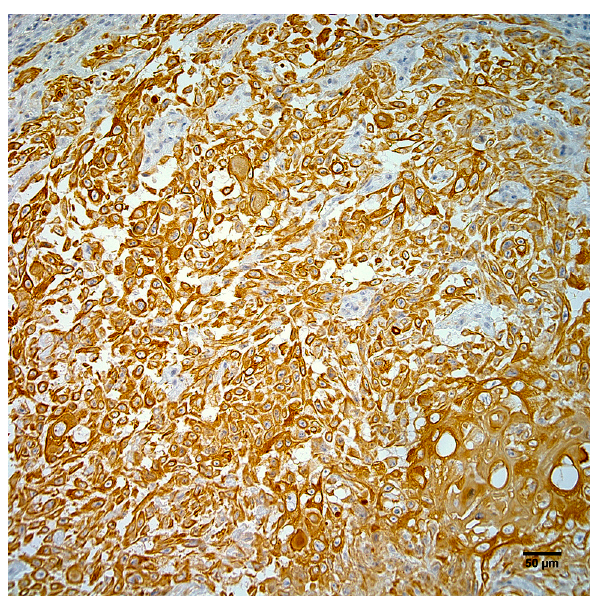
Figure 4. Neoplastic cells from the right hindlimb mass exhibit strong positive cytoplasmic immunostaining for pancytokeratin. Hematoxylin counterstain. Scale bar 50 µm.